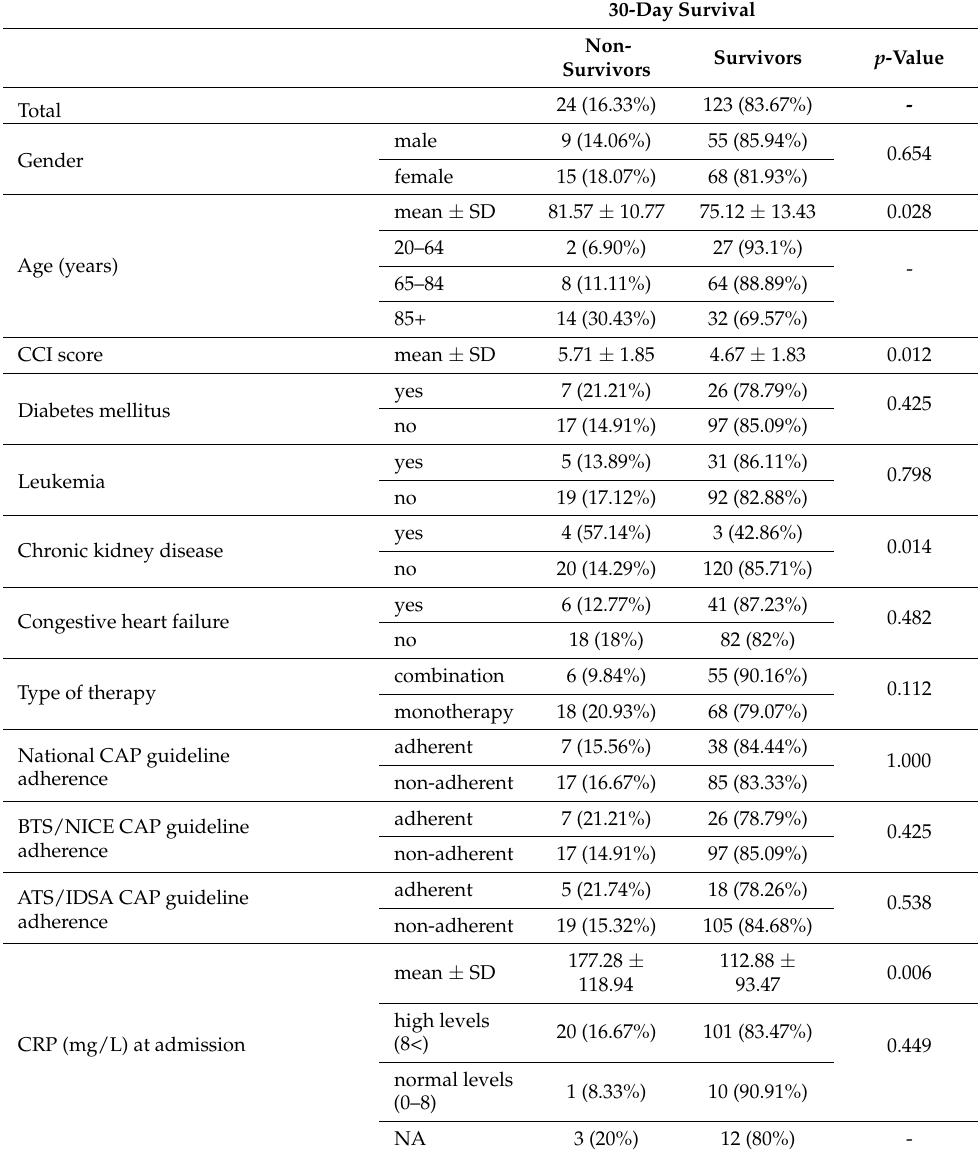
Table 5. Comparison of baseline and clinical characteristics of 30-day non-survivors and survivors among patients with